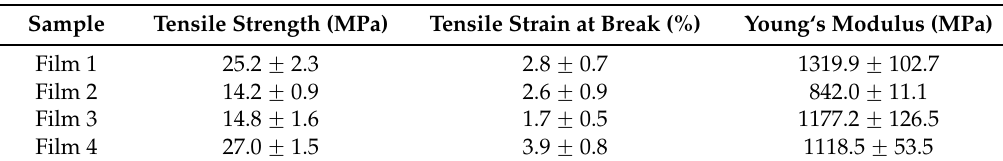
Table 3. Tensile testing results of the four blended films.